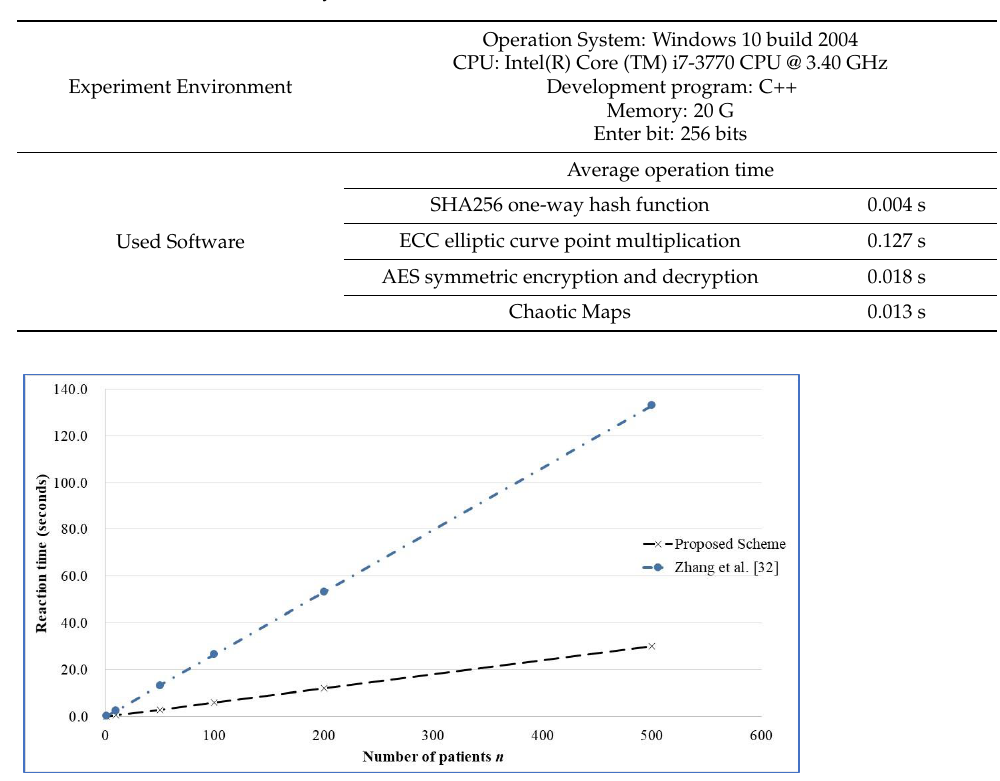
Figure 4. The reaction time of the sensor data transmission stage of Zhang et al. and proposed one.